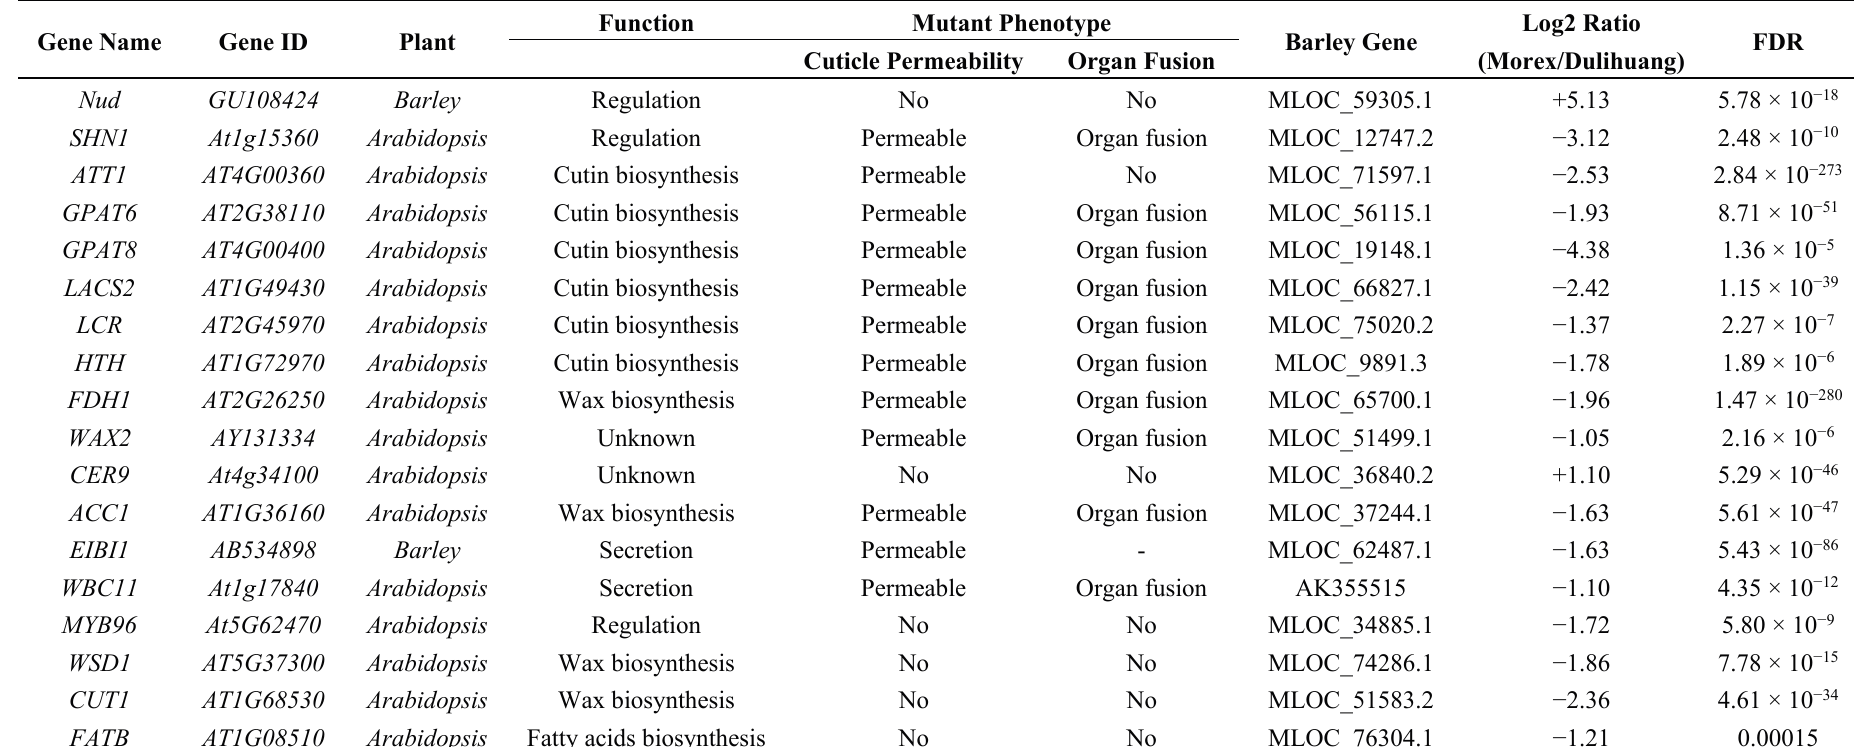
Table 2. Differentially expressed cuticle related